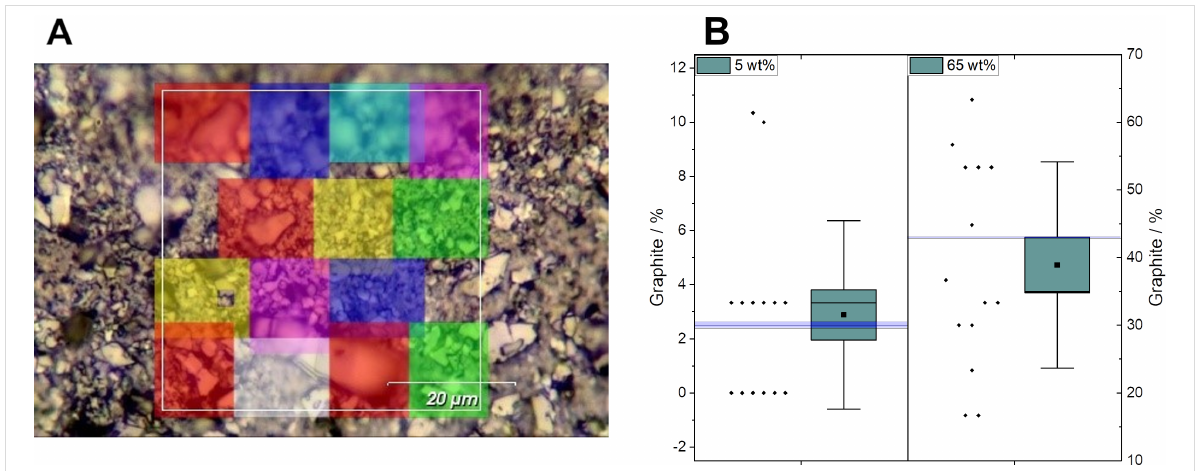
Figure 9: (A) Optical image of mapped area of sample with 65 wt % sediment added. Each coloured box shows a sub-map of 30 points taken from the full map of 441 points, indicated by the white-bordered box. (B) Calculated percentage of graphite for samples with 5 and 65 wt % sediment, based on the R 2 value from fitting the 2D peak. Each box shows the standard error of the mean, with the whiskers showing one standard deviation. The square marker indicates the mean value, while the light line across each box shows the median. The thick line across each panel shows the aver- age value from the full map area. The individual data points are shown to the left of each box, off-set in the x -direction for